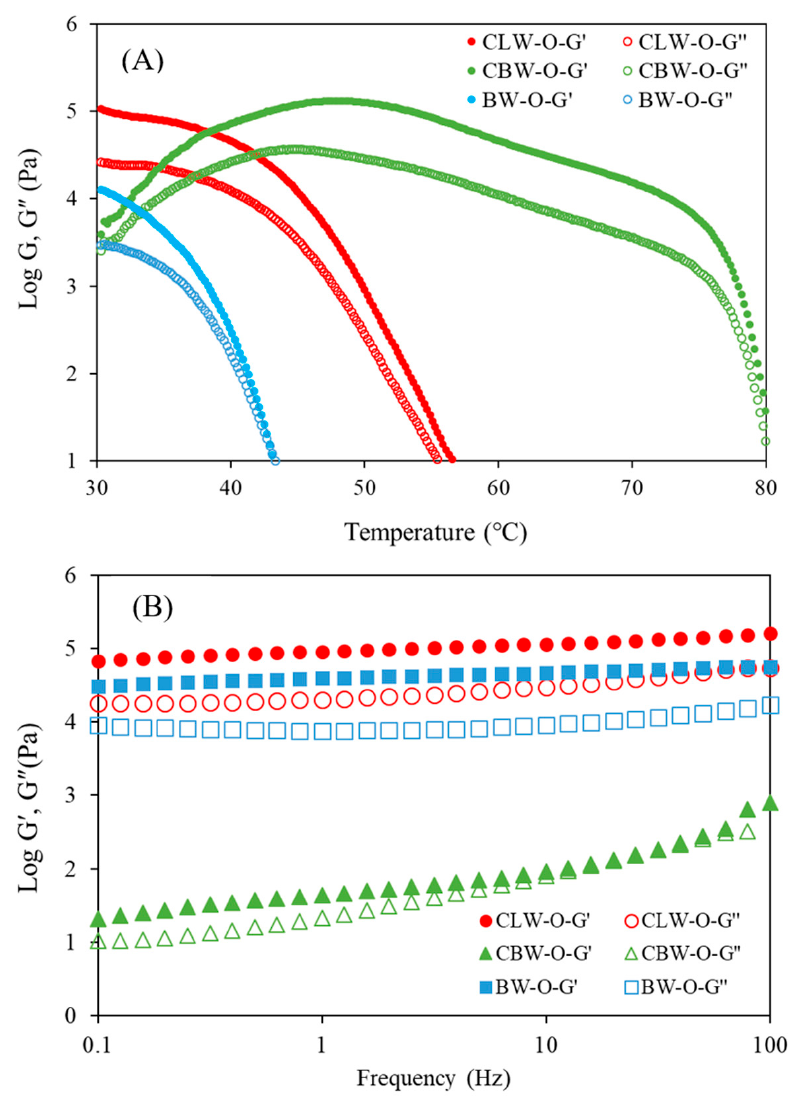
Figure 3. Viscoelasticity of oleogels as a function of temperature ( A ) and frequency ( B ). CLW-O: candelilla wax-oleogel, CBW-O: carnauba wax oleogel, BW-O: beeswax oleogel.